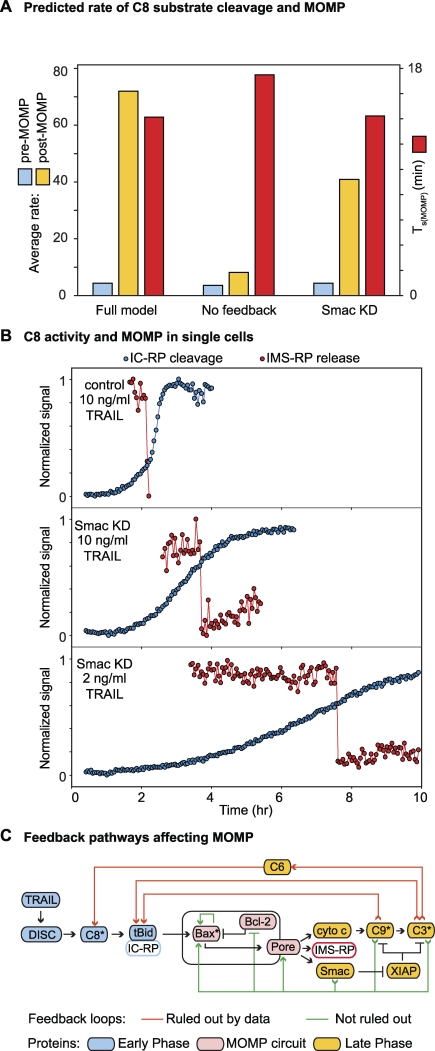
Rapid MOMP Independent of the Rapid Phase of Initiator Activity(A) Simulated values for the average rate of C8 substrate cleavage during the early (pre-MOMP) and late (post-MOMP) phases (left axis) and Ts of MOMP (right axis). Simulations were performed under conditions corresponding to stimulation by 2 ng/ml TRAIL.(B) Live-cell measurements of IC-RP cleavage and IMS-RP release in control or Smac-depleted cells treated with 10 or 2 ng/ml TRAIL. IC-RP and IMS-RP signals were normalized individually to allow comparison on the same axes.(C) Schematic diagram of potential feedback pathways regulating MOMP. The data shown in (B) are inconsistent with snap-action behavior resulting from feedback loops that act upstream of Bid cleavage (red arrows) but do not rule out the possibility that snap-action may arise from feedback loops that act downstream of Bid (green arrows). Some of the depicted loops are hypothetical and are shown for logical completeness.